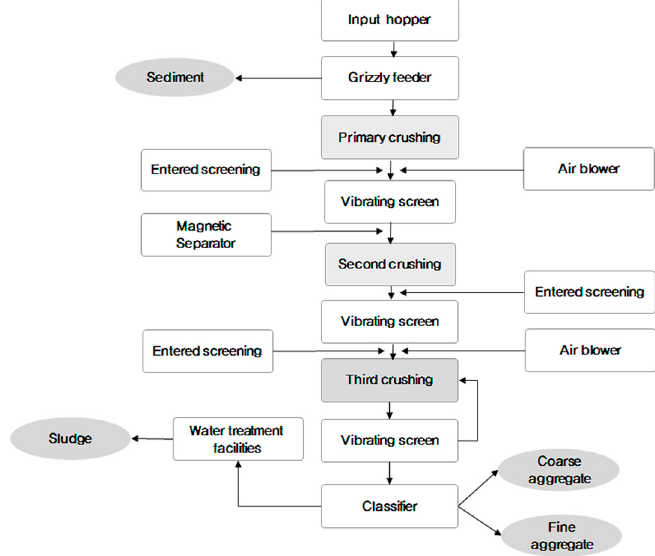
Figure 2. Wet production method process.